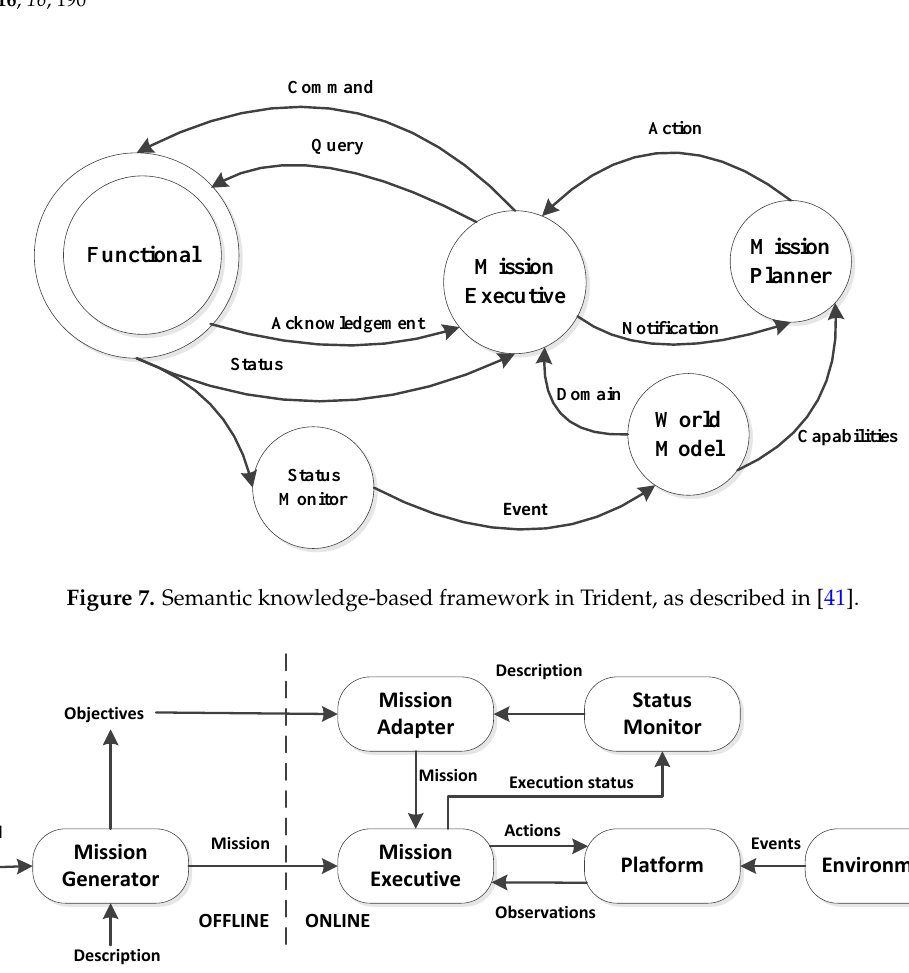
Figure 8. OODA loop for processing data, as described in [41].